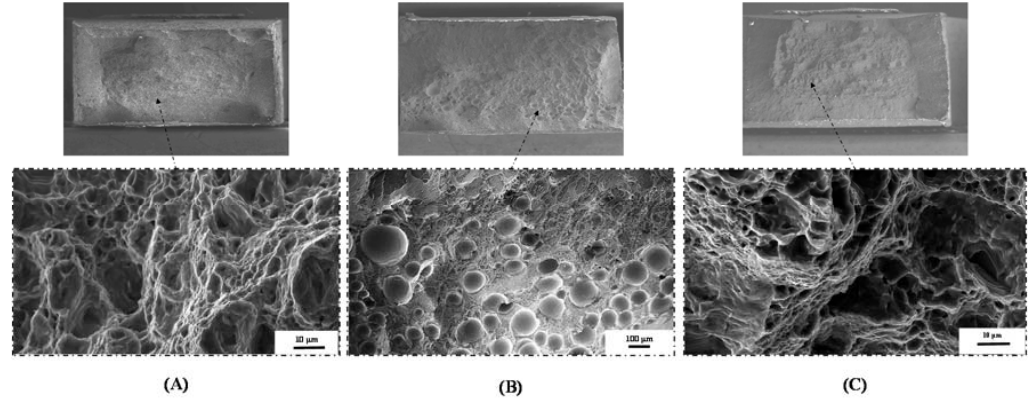
Figure 8. Typical SEM fractography of fractured tensile specimens. ( A ) CP-Ti similar, ( B ) Ti-64 similar, and ( C ) dissimilar.